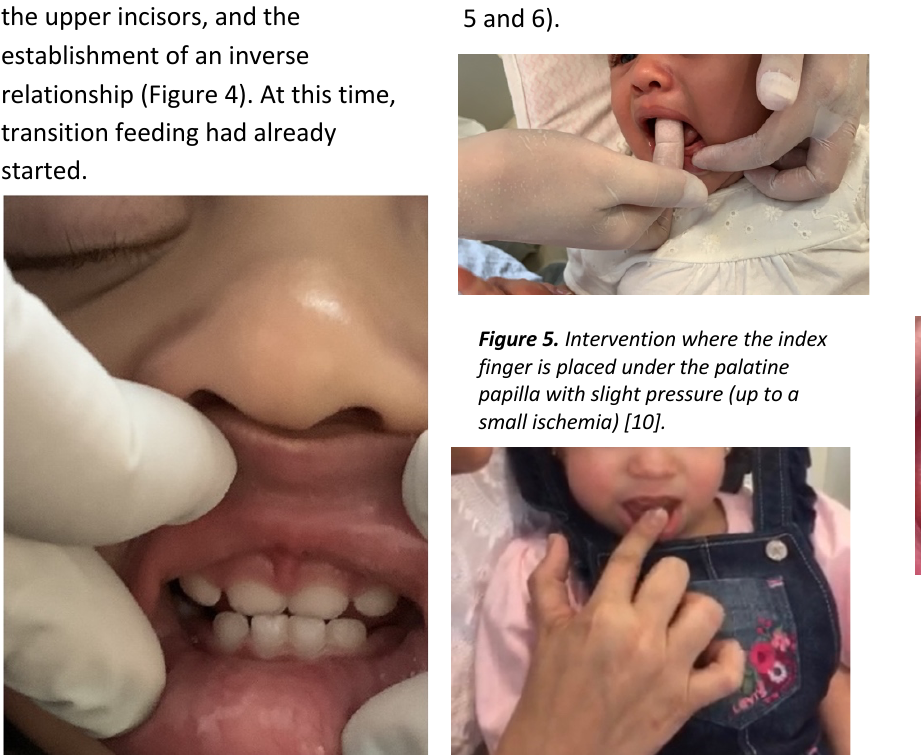
Figure 4. Observation of the relationship between the arches and the sleeping baby, in